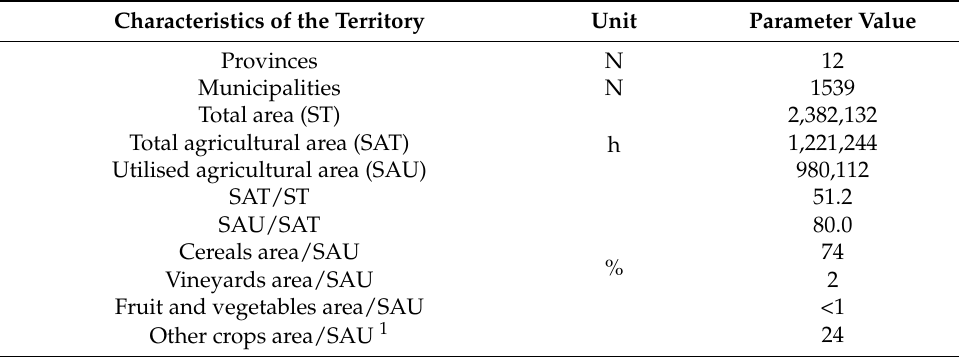
Table 1. Characteristics of the Lombardy territory and main agricultural crops. Characteristics of the Territory Unit Parameter Value